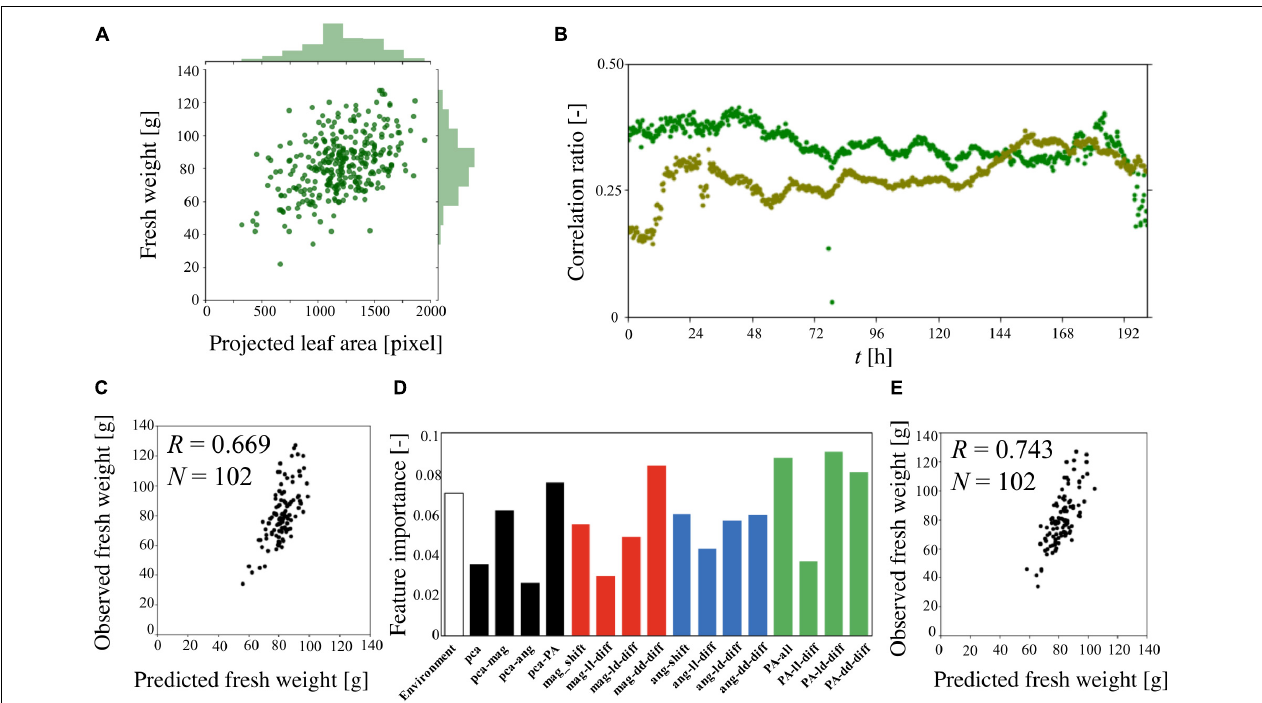
FIGURE 5 | Predicted fresh weight using machine-learning method. (A) Correlation ratio between fresh weight at the harvest and PA at t = 180 h. (B) Correlation ratio between the fresh weight and PA from t = 0–201 h. The dark green and light green indicate the different sets of experiments (dark green: 141 plants, light green: 92 plants). (C) Correlation ratio between observed fresh weight and predicted fresh weight using gradient boost regression (GBR). (D) Feature importance analysis of 115 features using GBR. (E) Correlation ratio between observed fresh weight and predicted fresh weight using support vector regression